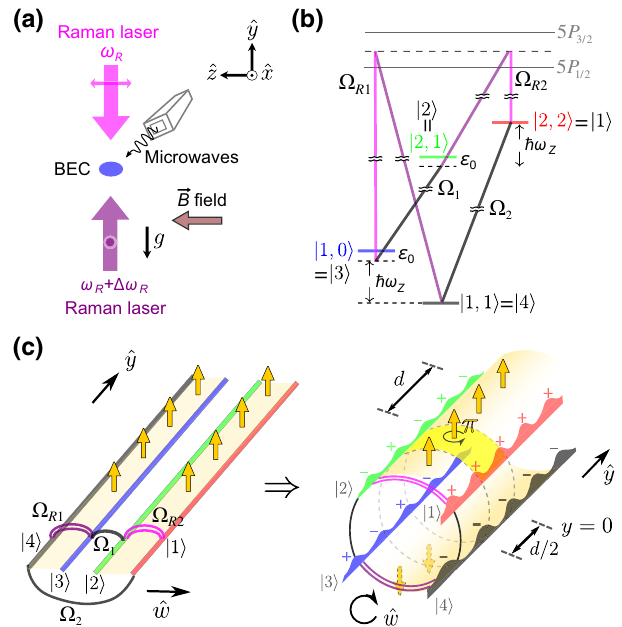
FIG. 1. Setup for realizing a synthetic Hall cylinder. (a) Coun- terpropagating Raman lasers with orthogonal linear polariza- tions (parallel to ˆ z and ˆ x ) and microwaves (propagating in the x - y plane) are applied to a BEC with typical atom number (1–2) × 10 4 . Gravity “ g ” is toward −ˆ y . (b) Internal spin states | 1 (cid:2) , | 2 (cid:2) , | 3 (cid:2) , and | 4 (cid:2) as discrete sites in the synthetic dimension ˆ w are cyclically coupled by Raman couplings (cid:2) R 1, R 2 and microwave couplings (cid:2) 1,2 . Linear Zeeman splitting (cid:2) ω Z = (cid:2) (cid:4)ω R is gener- ated by a bias magnetic field, where (cid:4)ω R is the Raman lasers’ angular frequency difference. The quadratic Zeeman shift is ε 0 ≈ 2.4 E r . (c) Connecting two edges of a Hall strip (left) gives rise to a Hall cylinder (right), a cylindrical surface threaded by synthetic magnetic fields (yellow arrows in shaded regions). The magnetic flux through a unit plaquette (highlighted area) formed by four maxima of the emergent BEC density modula- tions (wavy patterns with a periodicity of d / 2; note that such density modulations do not occur in the Hall strip) corresponds to an Aharonov-Bohm phase of π . The phase (with + and − respectively denoting 0 and π at positions of maximum density) of each spin component has a periodicity of either d or d / 2.